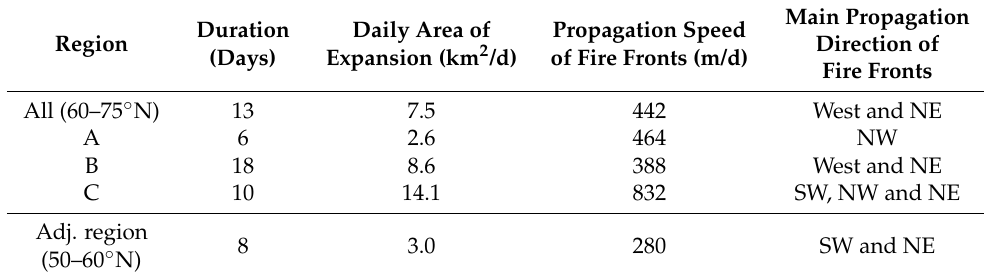
Table 3. Propagation speed, direction, and duration of individual fires.